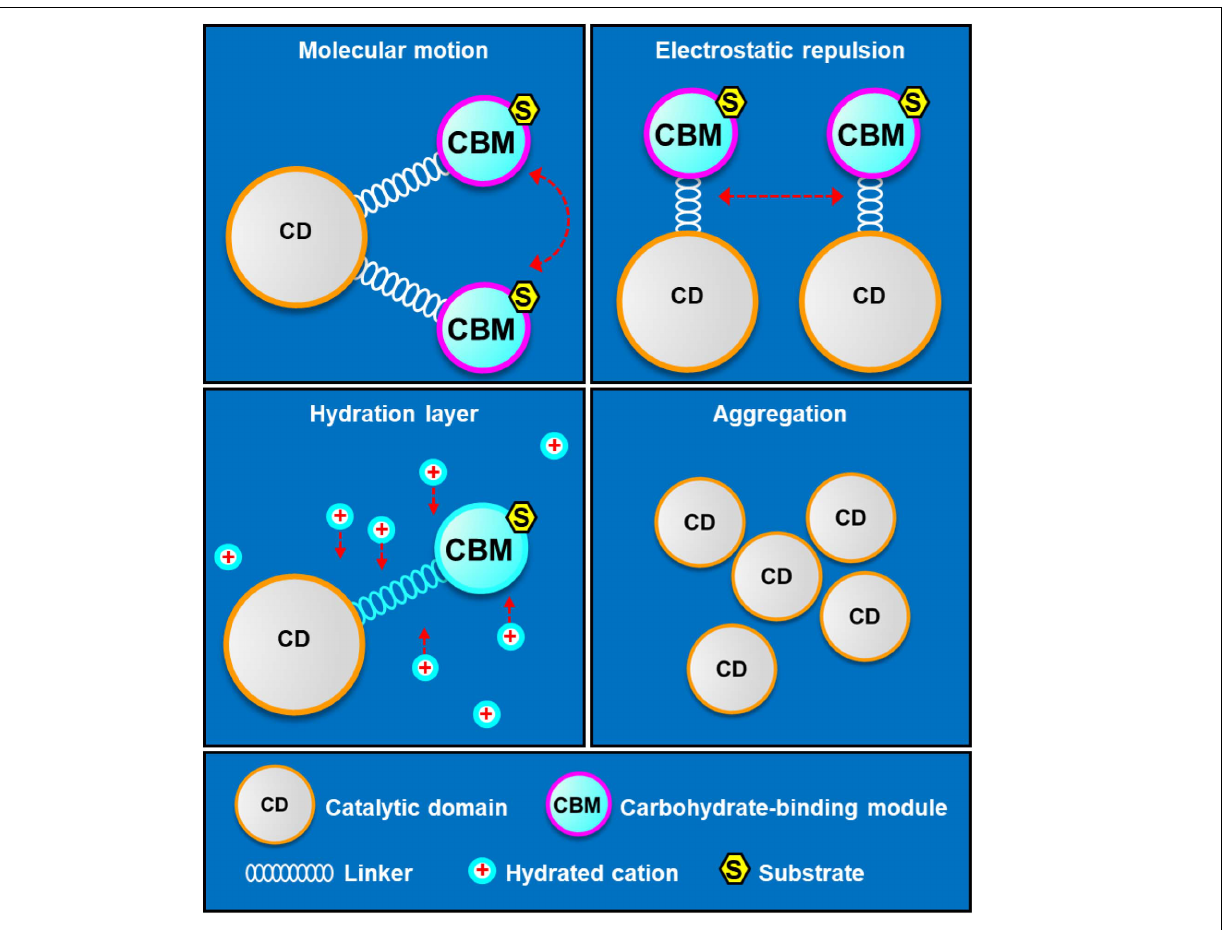
FIGURE 8 | Schematic diagram of structural determinants of cold adaptation and salt tolerance of SdG5A. The highly flexible linker-CBM structure allows an active molecular motion, which guarantees searching and capturing substrates for catalytic domain. The high density of identically charged residues in the linker-CBM region allows appreciable electrostatic repulsion, which prevents protein aggregation and inactivation. The acidic residue-rich linker-CBM structure allows the formation of hydration layer, which help protein maintain in soluble state.